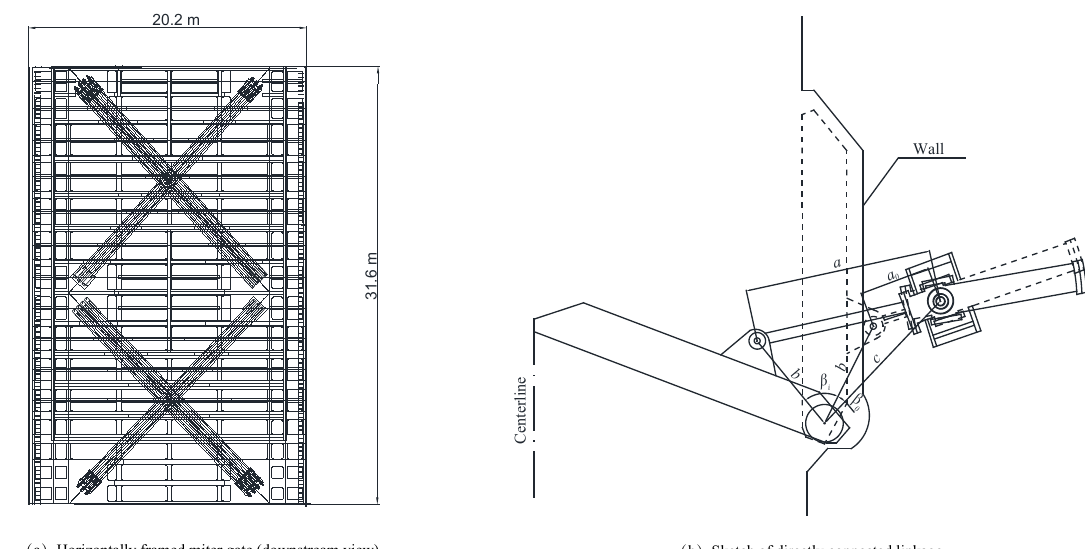
Figure 1. The ship locks of Changzhou hydro-junction.